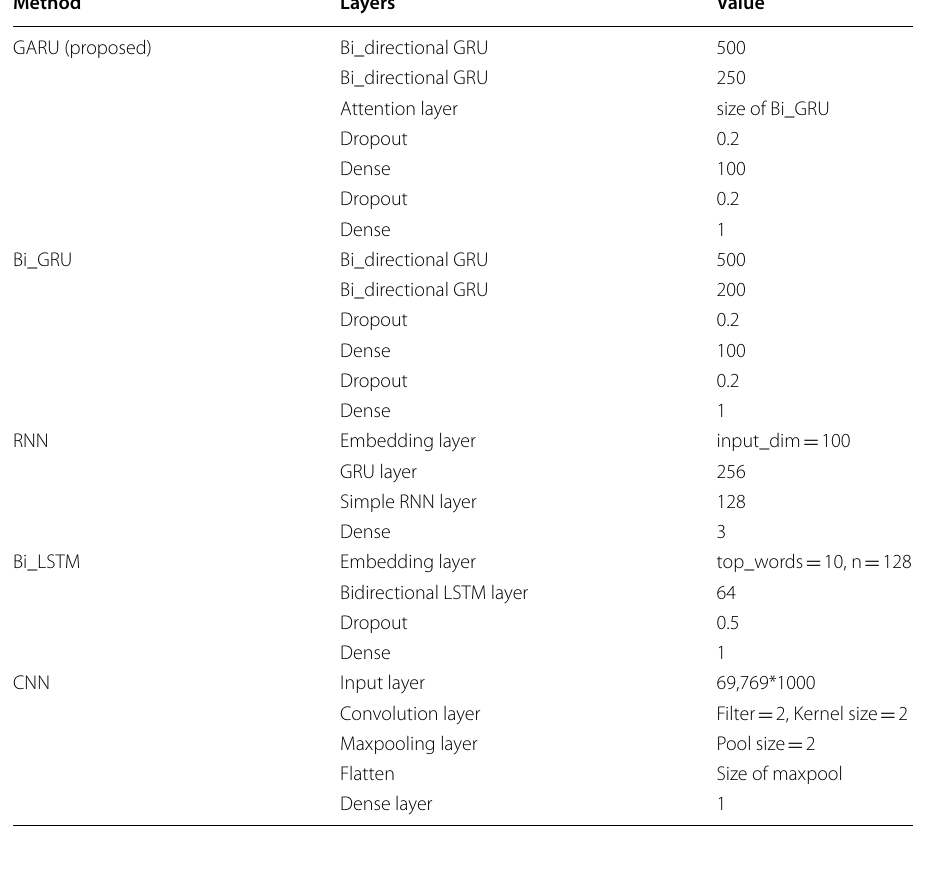
Table 3 Simulation parameters of proposed and existing implemented methods Method